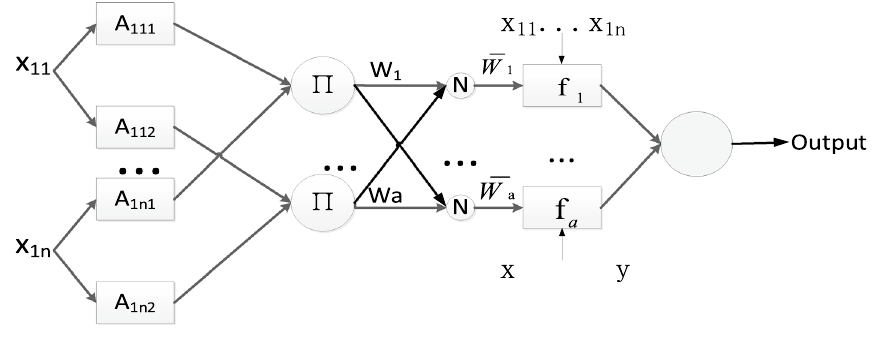
Figure 3. Architecture of